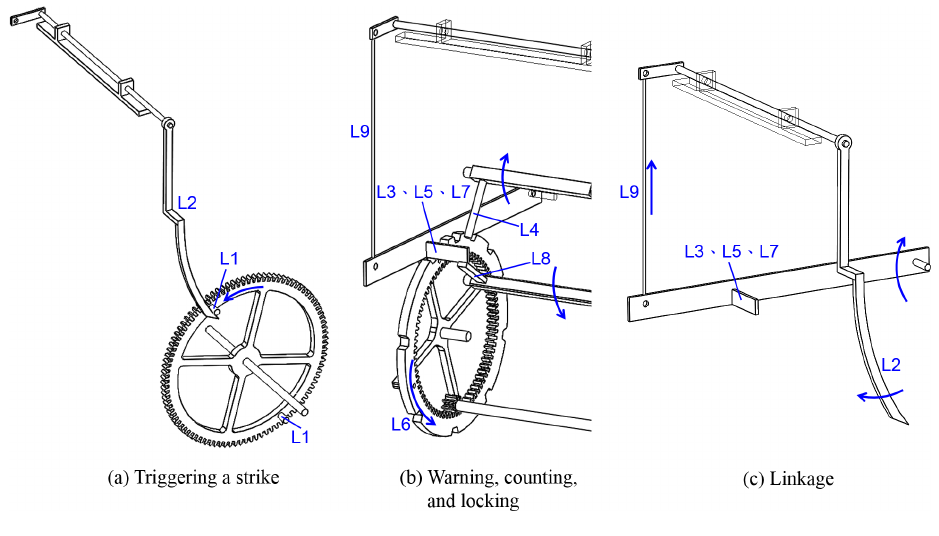
Figure 8. Structure and operation of the N1 trigger mechanism.